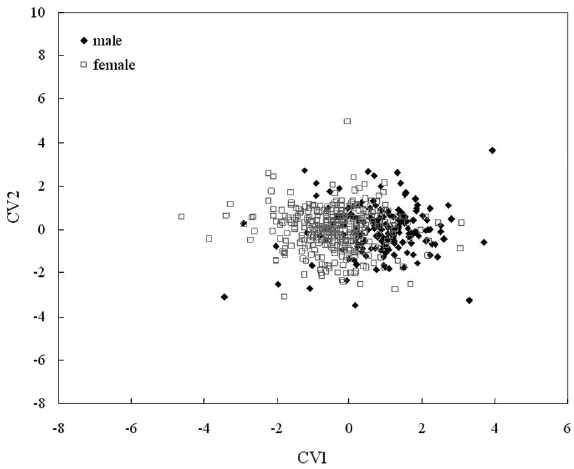
F Ig . 5. – Plot of canonical variables (CV1 vs. CV2) for male and female beak morphological variables of D. gigas.